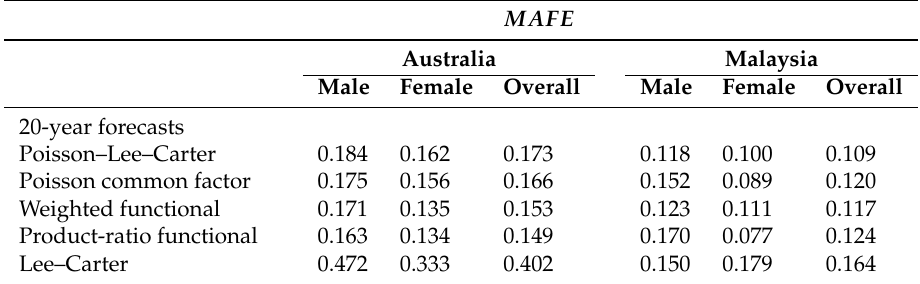
Table 1. Mean Absolute Forecast Error ( MAFE ) of log death rates for males and females by method, gender and